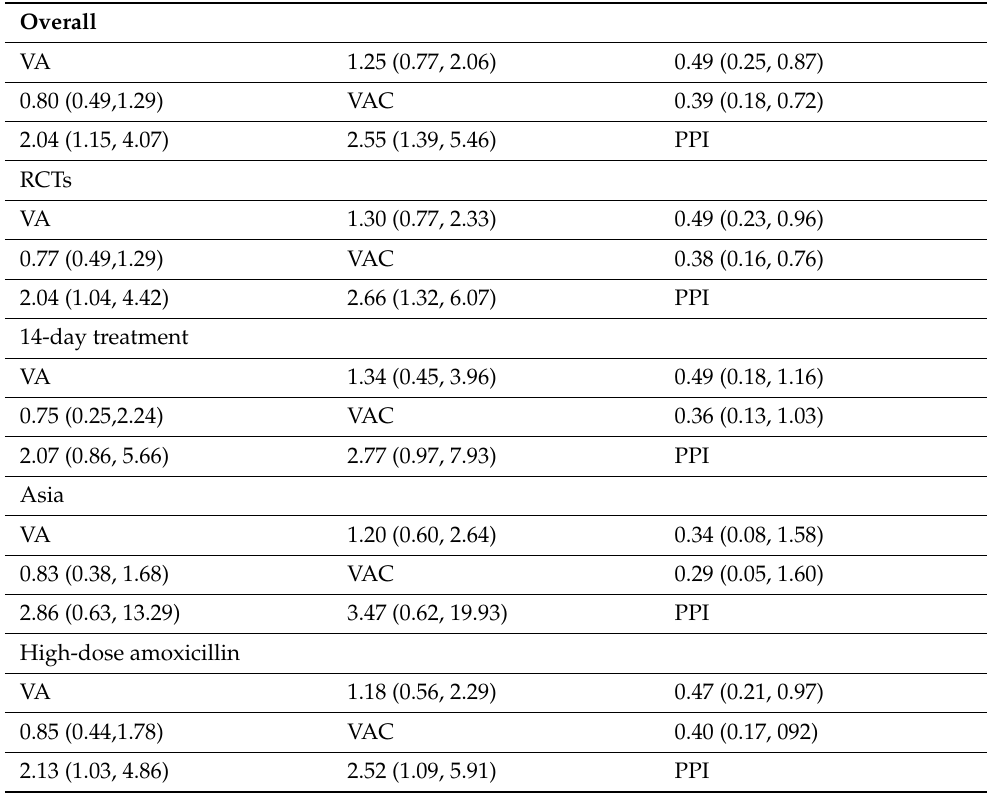
Figure 3. Comparison−adjusted funnel plot. ( A ) Adverse events, ( B ) Efficacy A, Vonoprazan dual therapy; B, vonoprazan triple therapy; C, PPI triple therapy.